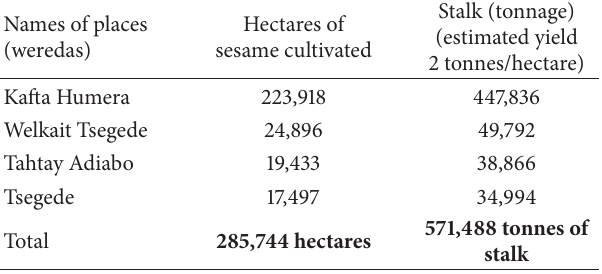
Table 1: Quantitative data of sesame stalk in Humera.